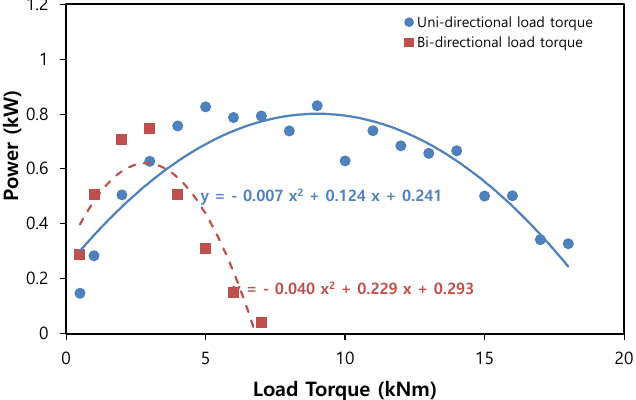
Figure 12. Comparison of the extracted power at H s = 0.75 m and T p = 5.50 s. Furthermore, the extracted powers in response to significant wave height were in- vestigated considering uni-directional PTO load torque. The extracted powers in response to increasing uni-directional PTO load torque at H s = 0.50, 0.75, 1.00, and 1.25 m and T p = 5.50 s were compared, as shown in Figure 13. The optimal PTO load torque in- creased with increasing significant wave height. The extracted power was maximized over H s = 0.50, 0.75, 1.00, and 1.25 m, when a proper PTO torque was selected in the 9–14 kNm range because the extracted power curves of second-order polynomial at uni-directional load torque have a mild tendency.